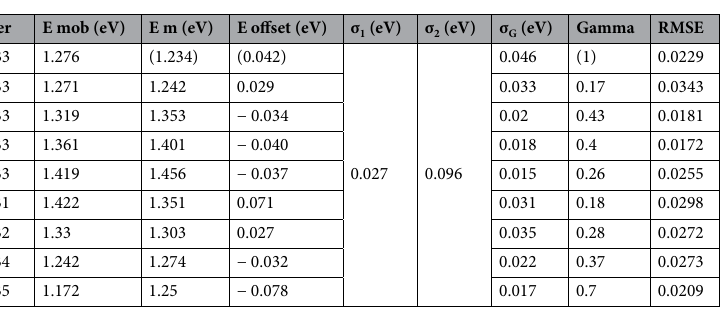
Table 2. Summary of best-fit model parameters for each device. Localisation energies and the evaluation wavelength ranges can be found with the raw data in the supplementary material. The values for device G1B3 which are not considered accurate due to poor state filling are enclosed in parentheses.